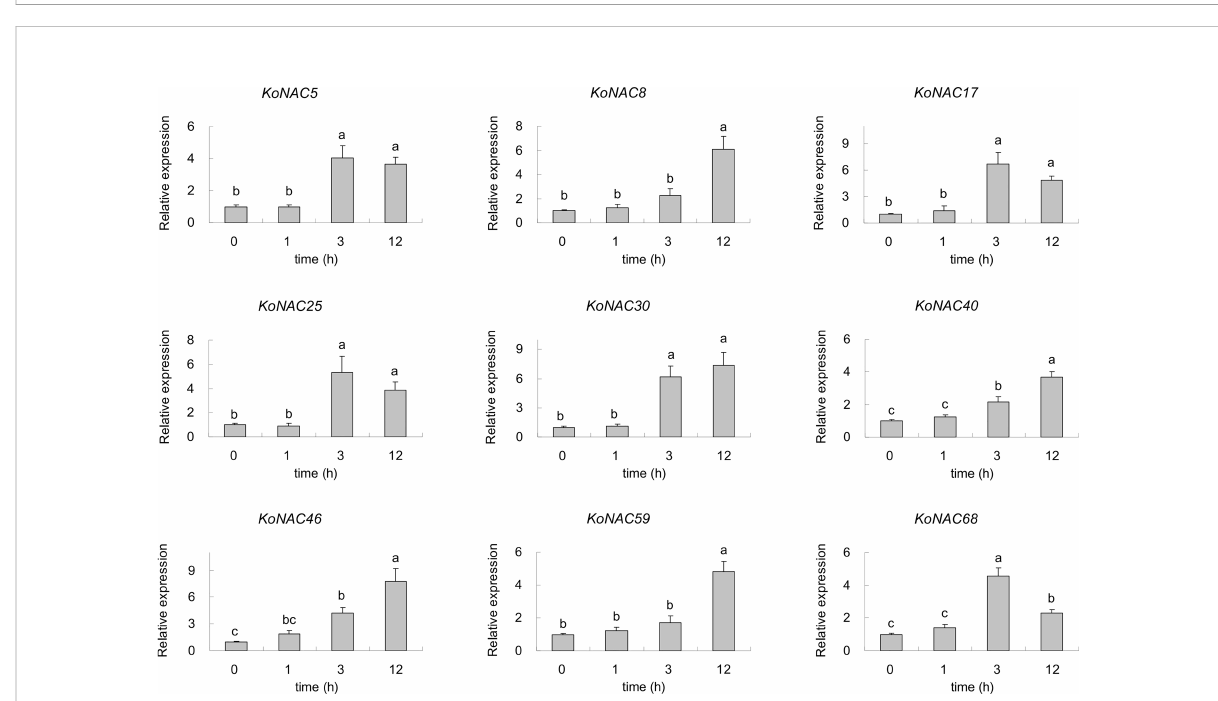
FIGURE 10 The expression pro fi les of nine potential KoNACs in response to chilling stress. The relative expression levels of nine KoNACs were measured in plants subjected to a temperature of 4°C for 0, 1, 3, and 12 h. The transcript levels of the selected genes were assessed via qRT - PCR and normalized to 18S rRNA levels. The error bars represent the standard errors. The values with the same letter are not signi fi cantly different according to Duncan ’ s multiple range test ( P < 0.05; n